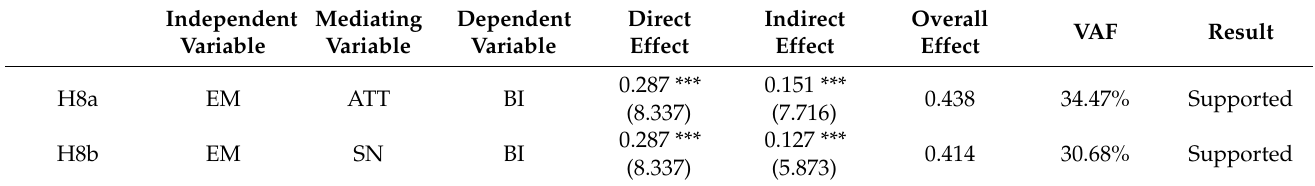
Table 6. Mediation effects testing